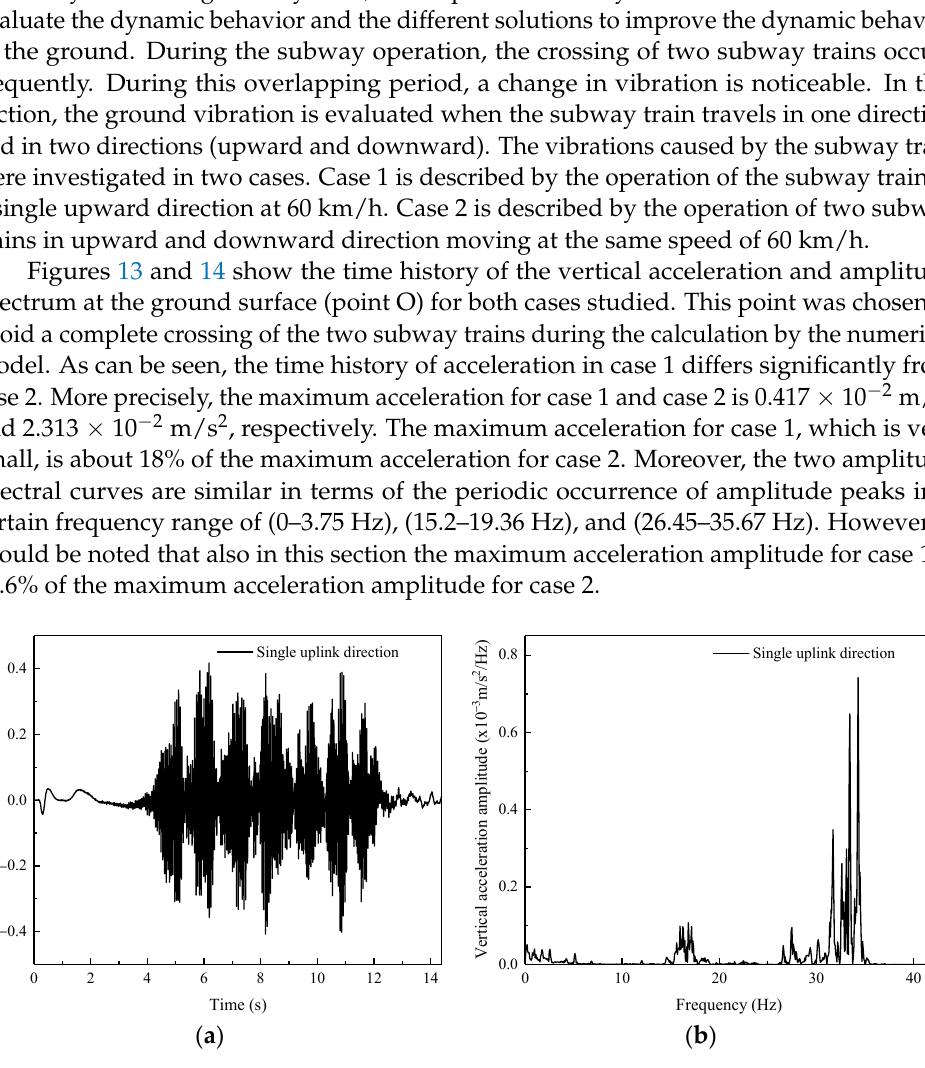
Figure 14. Vertical vibration at point O during the uplink and downlink operations. ( a ) Time history of dynamic acceleration; ( b ) acceleration amplitude-frequency. From this analysis, it is clear that consideration of the ground vibrations caused by the two moving subway trains in the upward and downward directions is critical to evaluate the vibrations of the surrounding buildings and the effectiveness of the improvement methods. This analysis highlights the importance of considering the vibration effect caused by two trains traveling simultaneously in the upward and downward directions. 5. Numerical Study of the Performance of the CFRP-Reinforced Tunnel